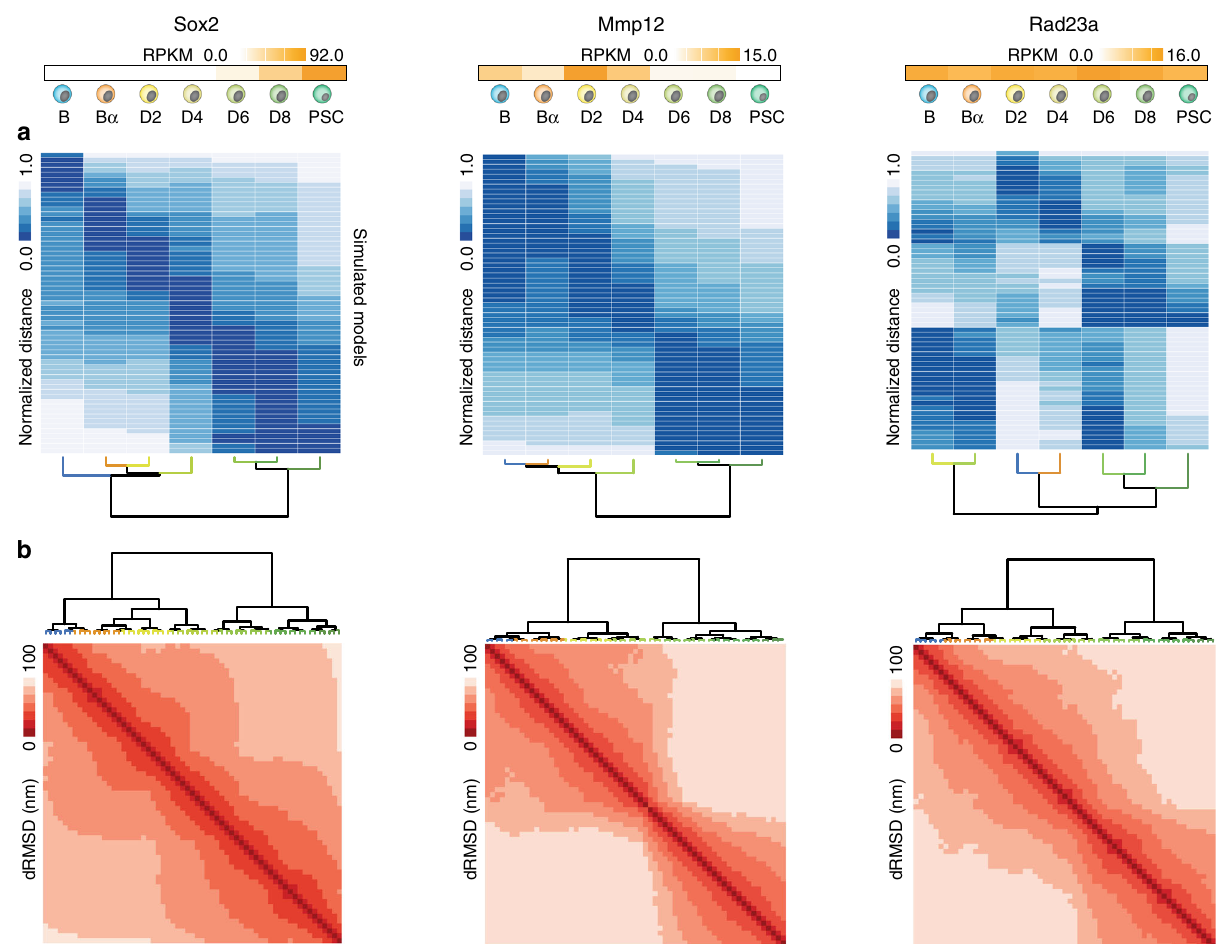
Fig. 2 Dynamic structural chromatin reorganization linked to transcriptional activity. Top of the fi gure indicates expression level (RPKM) for each of the selected loci at each reprogramming stage 35 . a Heat-map of the normalized spearman rank correlations computed for each pair of 60 model contact maps (i.e. one map every 1-time step of the simulation) against each of the seven Hi – C interaction maps obtained during the reprogramming process. b Heat- map of the distance RMSD (dRMSD) between all models within a simulation. Each heat-map is accompanied by the corresponding dendrogram obtained from the clustering analysis ( “ Methods ”